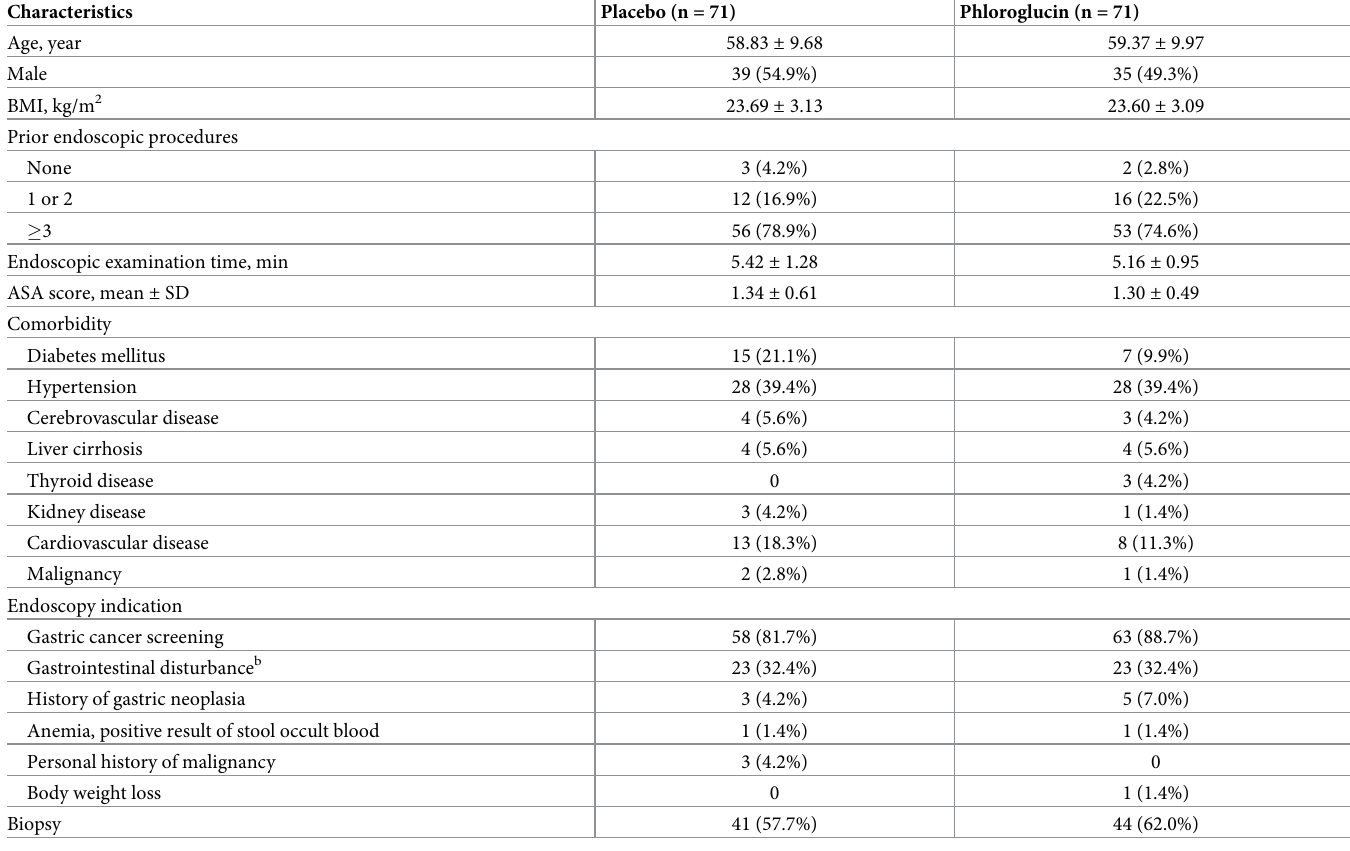
Table 2. Baseline patient characteristics (n = 142).